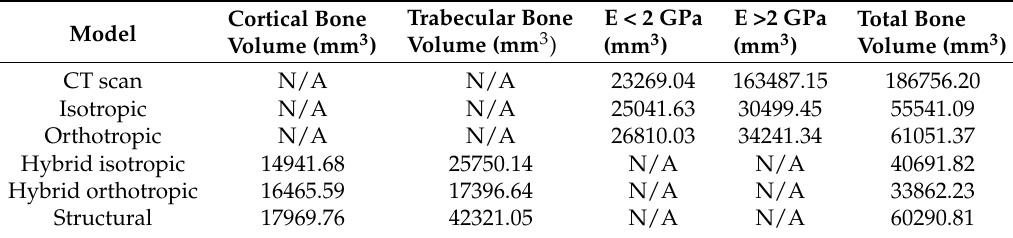
Table 8. Predicted bone volumes for the adapted models and the CT scan derived